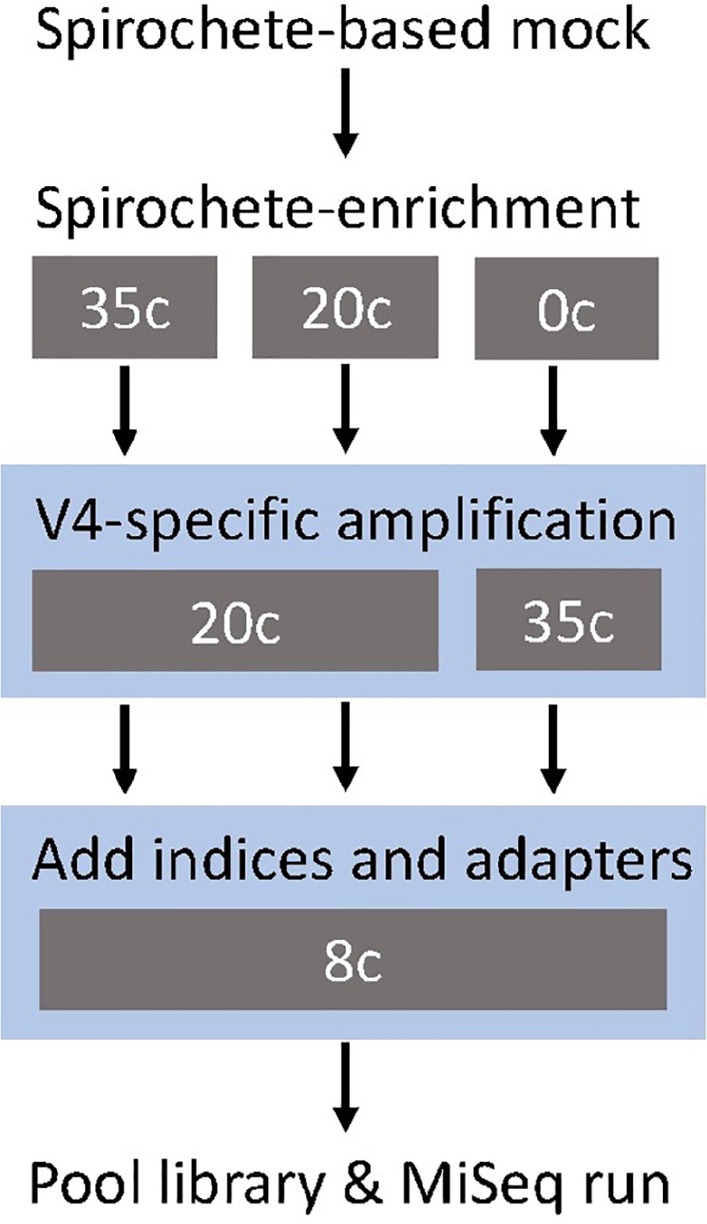
Study design of the metataxonomic assay targeting the V4-region of the 16S rRNA gene. The gray boxes show the tested cycle (c) conditions for each step. The blue shading indicates the modular two-step library preparation.